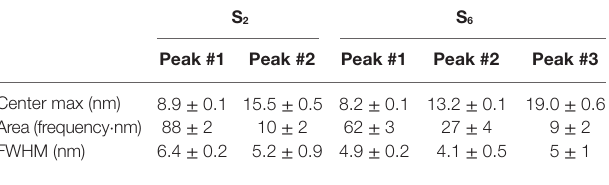
TaBle 1 | summary of the deconvoluted peaks for studying the particle size distribution of samples s 2 and s 6